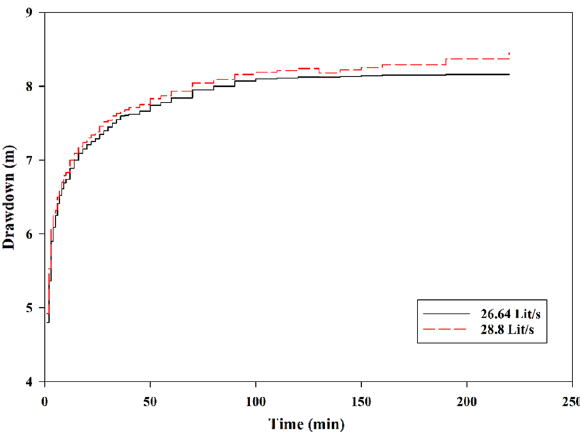
Fig. 2 Changes in groundwater drawdown affected by pumping with a constant discharge of 26.64 and 28.8